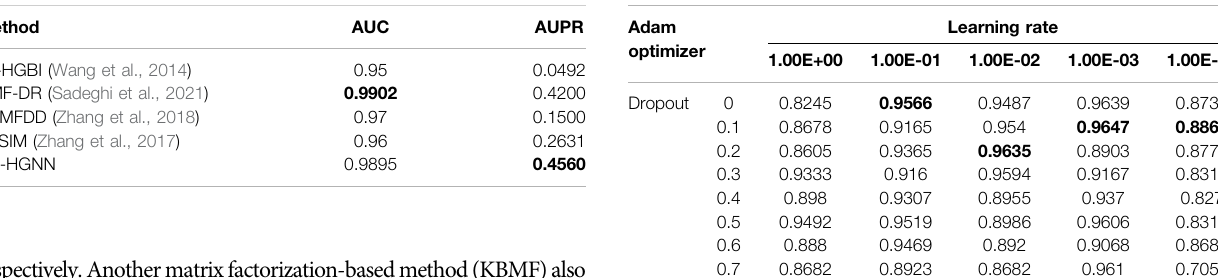
TABLE 3 | Results of DR-HGNN on the TL-HBGI dataset (Wang et al., 2014). TABLE 4 | AUC ROC results for DR-HGNN based on different